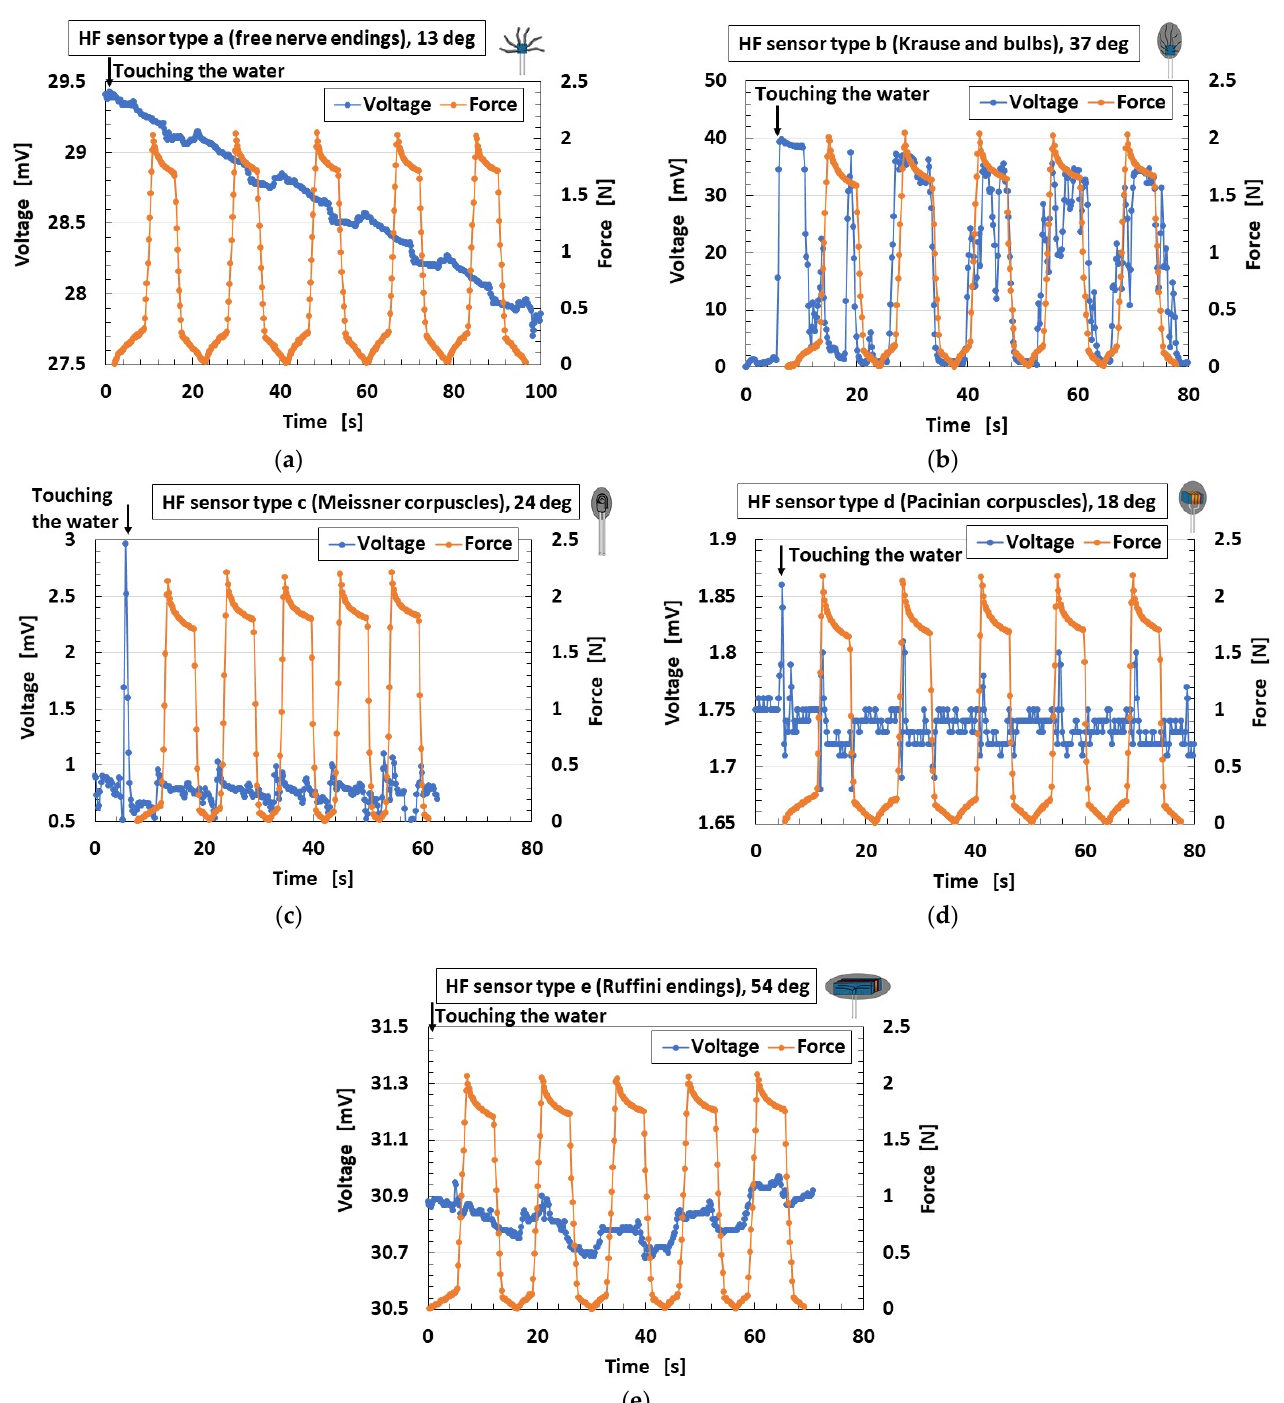
Figure 15. Photographs of the soft bending finger: ( a ) before touching; ( b ) upon touching.